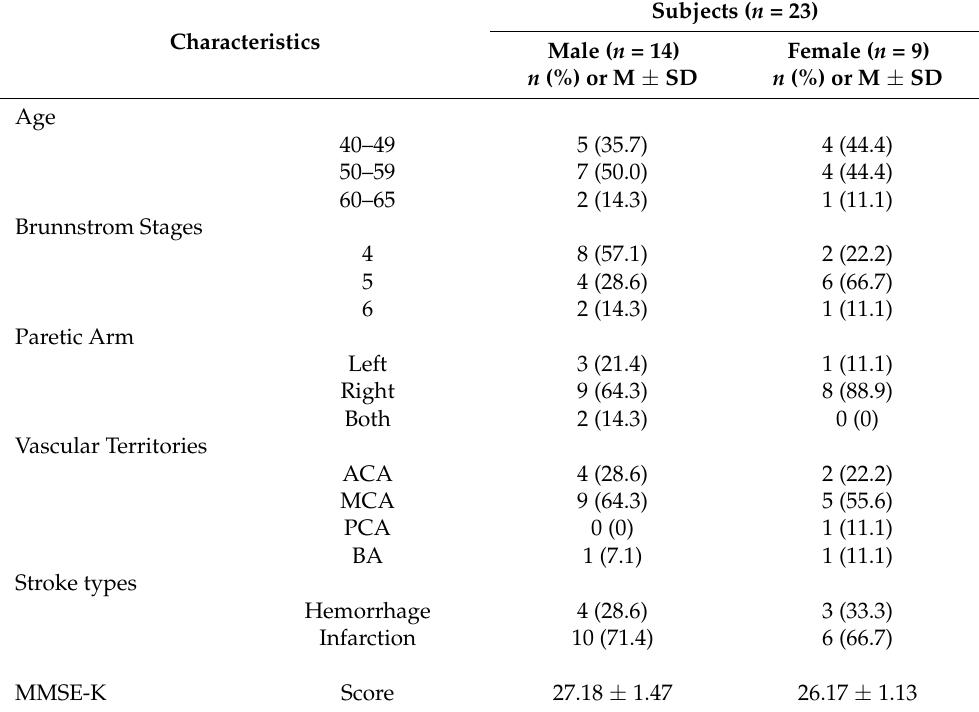
Table 1. Examination of homogeneity for general characteristics of the participants.